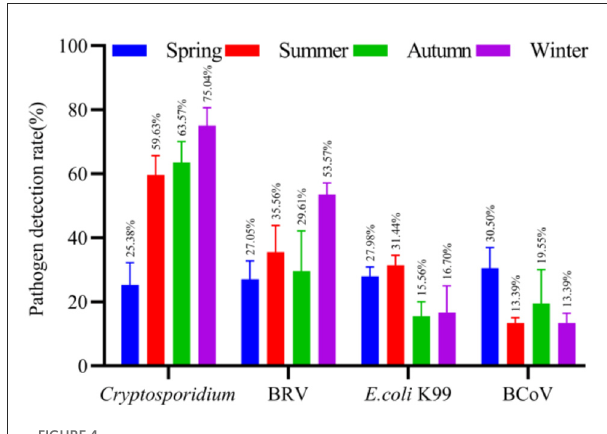
FIGURE4 The detection rate of normal and diarrhea samples in different seasons. The number of cattle farms in Ningxia where samples were collected at different seasons, and the detection rates of Cryptosporidium , BRV, E. coli K99, and BCoV in each cattle farm were